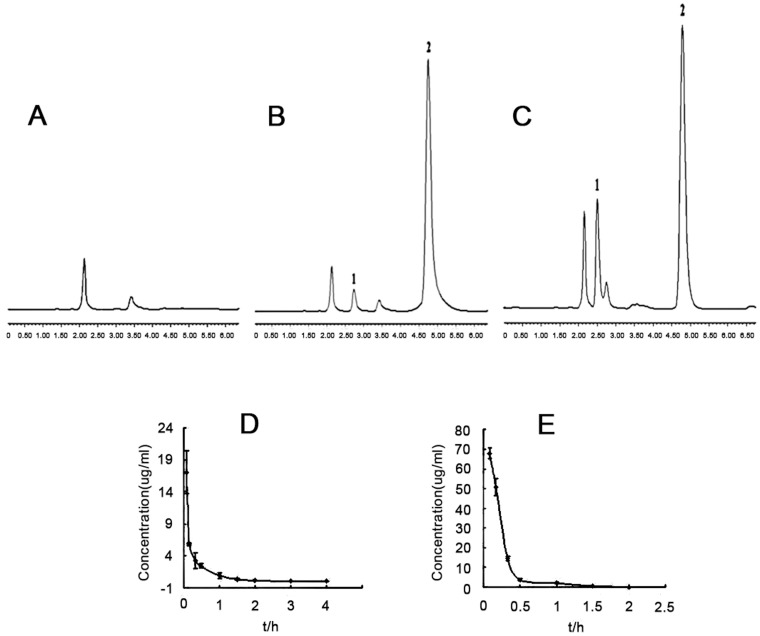
In vivo pharmacokinetics test were performed in mice by high-performance liquid chromatography.Chromatogram was shown in (a) for blank plasma, (b) for plasma with 5-FU and 5-Bru, and (c) for sample in plasma with 5-FU and 5-Bru.(5-Bru as endo-parameter). The C-T-curve indicated that the mean residence time for (d) 5-FU-NPs is 0.490 longer than (e) 5-FU solution (0.271 h). And the concentration can not be identified 2 h later for 5-FU solution group.